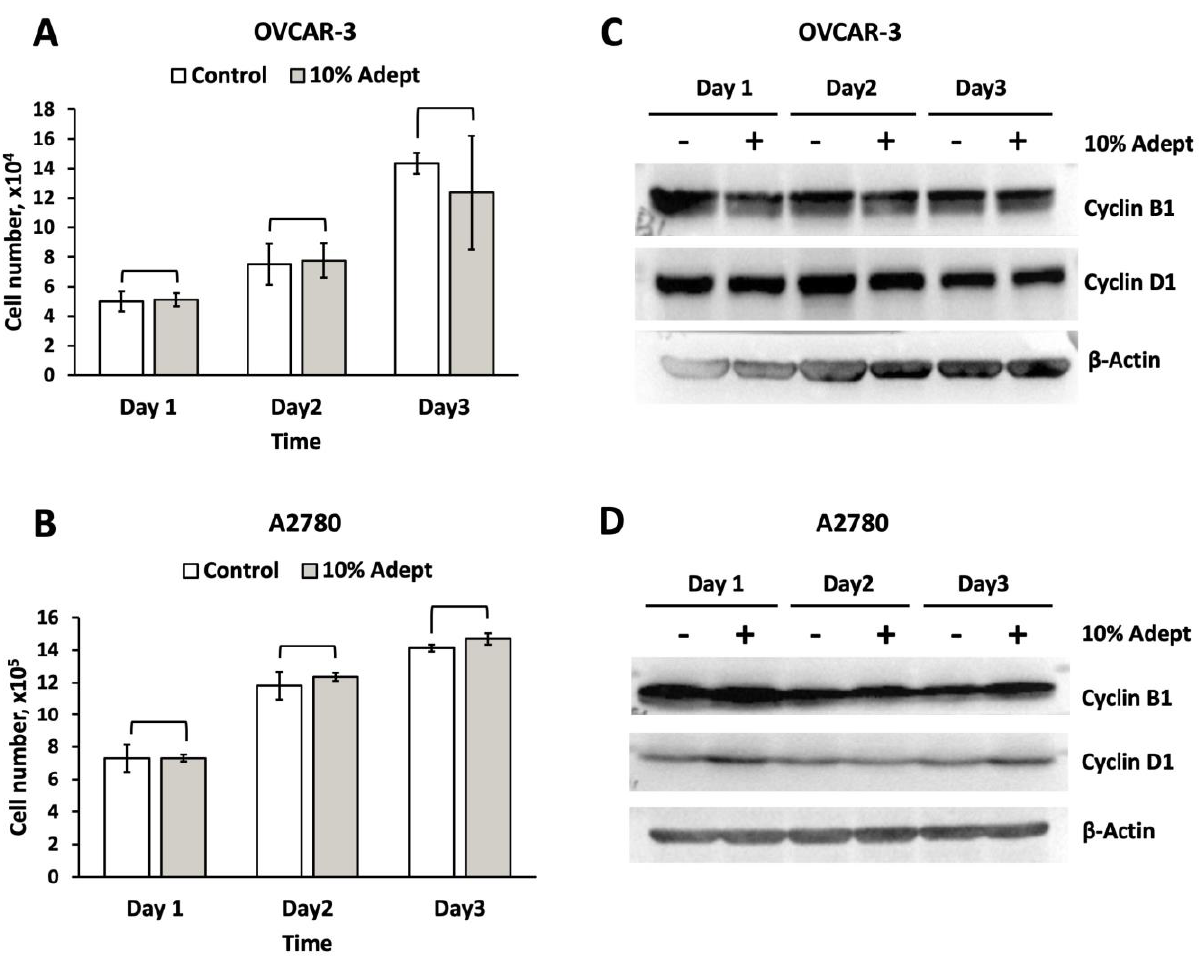
Figure 2. Adept ® solution does not affect OVCAR-3 and A2780 cell growth and proliferation at various time-points. ( A ) OVCAR-3 and ( B ) A2780 cells were plated in six-well plates in triplicate at 1.1 × 10 4 cells/cm 2 and 4 × 10 3 cells/cm 2 , respectively, in regular medium for 3 days, then 10% Adept ® solution ( v / v , equal to 0.4% icodextrin) was added; control cells were cultured in regular medium alone. Triplicate samples were harvested after 1, 2 or 3 days of icodextrin treatment, and then cells were trypsinized. Total live cell numbers were counted. The ratio of cell growth was calculated by normalizing the numbers of treated cells to the number of control cells ( n = 3 × 2). Total cell lysates from ( C ) OVCAR-3 and ( D ) A2780 cells at various time points were subjected to Western blot analysis to quantify the cell cycle regulation proteins cyclin B1 and cyclin D1; β -actin was used as a loading control.